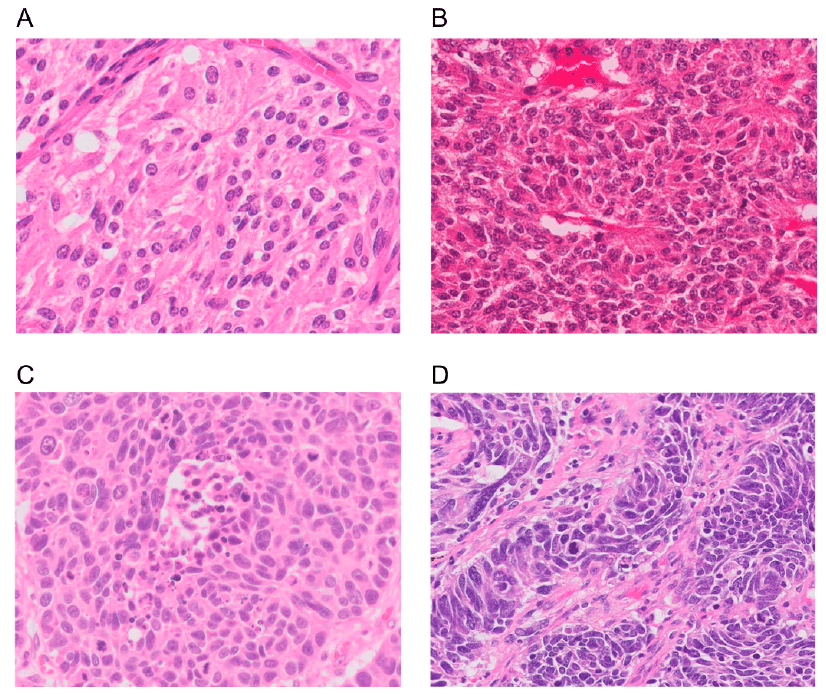
Figure 1. Morphology of a lung neuroendocrine neoplasm. ( A ) A typical carcinoid showing solid nests with zellballen patterns; the tumor cells are uniform with a moderate amount of eosinophilic cytoplasm. ( B ) An atypical carcinoid showing rosette formation. ( C ) Large-cell neuroendocrine carcinoma showing organoid nesting and palisading patterns; tumor cells have abundant eosinophilic cytoplasm, coarsely granular chromatin, and prominent nucleoli. ( D ) Small-cell lung carcinoma showing sheets of small cells with scant cytoplasm, finely granular chromatin, and mitoses. Magnification: ×40. Adapted from Yoshimura et al. [5].